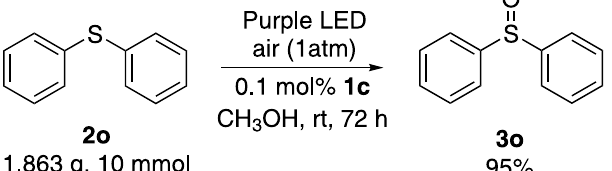
Figure 3. Gram scale synthesis of 3o .